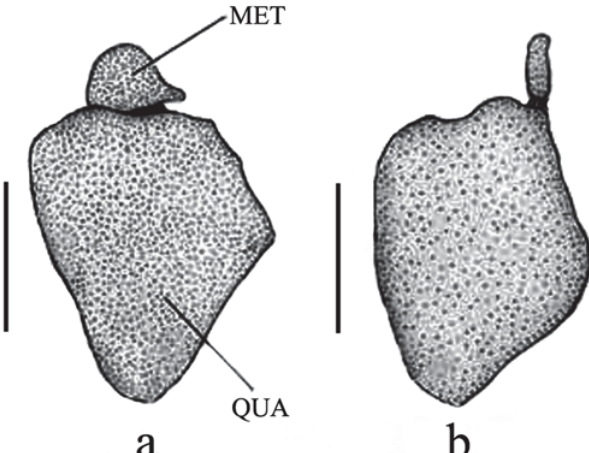
Fig. 3. Dorsal view of the quadrate and metaperygoid of ( a ) Bunocephalus erondinae , paratype, MCP 33664 (68.5 mm SL) and of ( b ) B . doriae , MCP 13176 (50.9 mm SL). MET, metapterygoid, and QUA, quadrate. Scale bar = 1